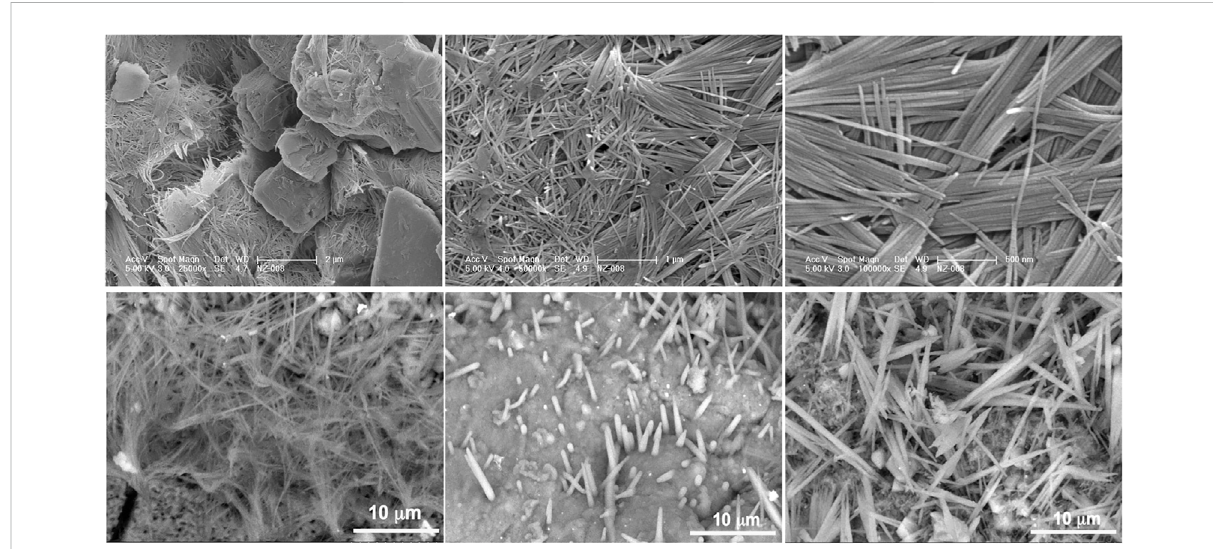
FIGURE 3 Scanning Electron Microscope images of the fi brous matrix of natural samples from carbonate fault mirrors (top) and fi brous mats forming through hydrothermal processes (bottom, Head et al., 2018 and this study). Fibrous minerals have nano-size diameter and length of a few microns, altogether creating disordered and entangled structures; (bottom central) growth of mineral fi bers through vapor-transport reactions induced via hydrothermal